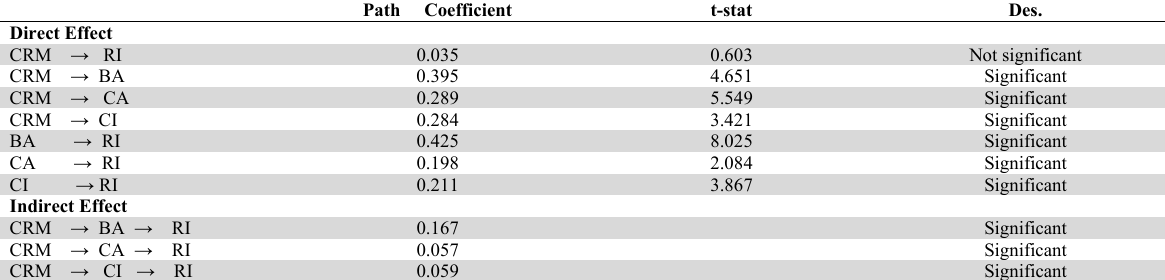
Result of Hypothesis